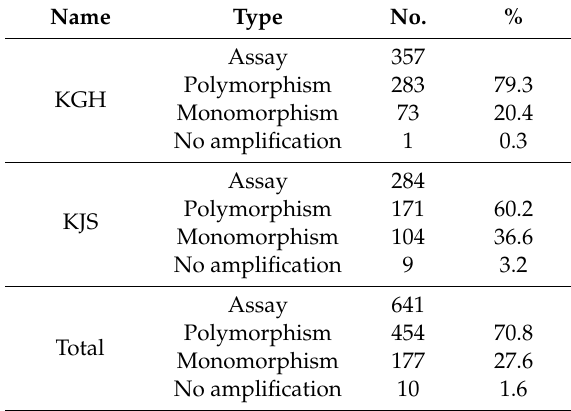
Table 2. Summary of validation of designed kompetitive allele-specific PCR (KASP) markers with 15 Korean japonica rice